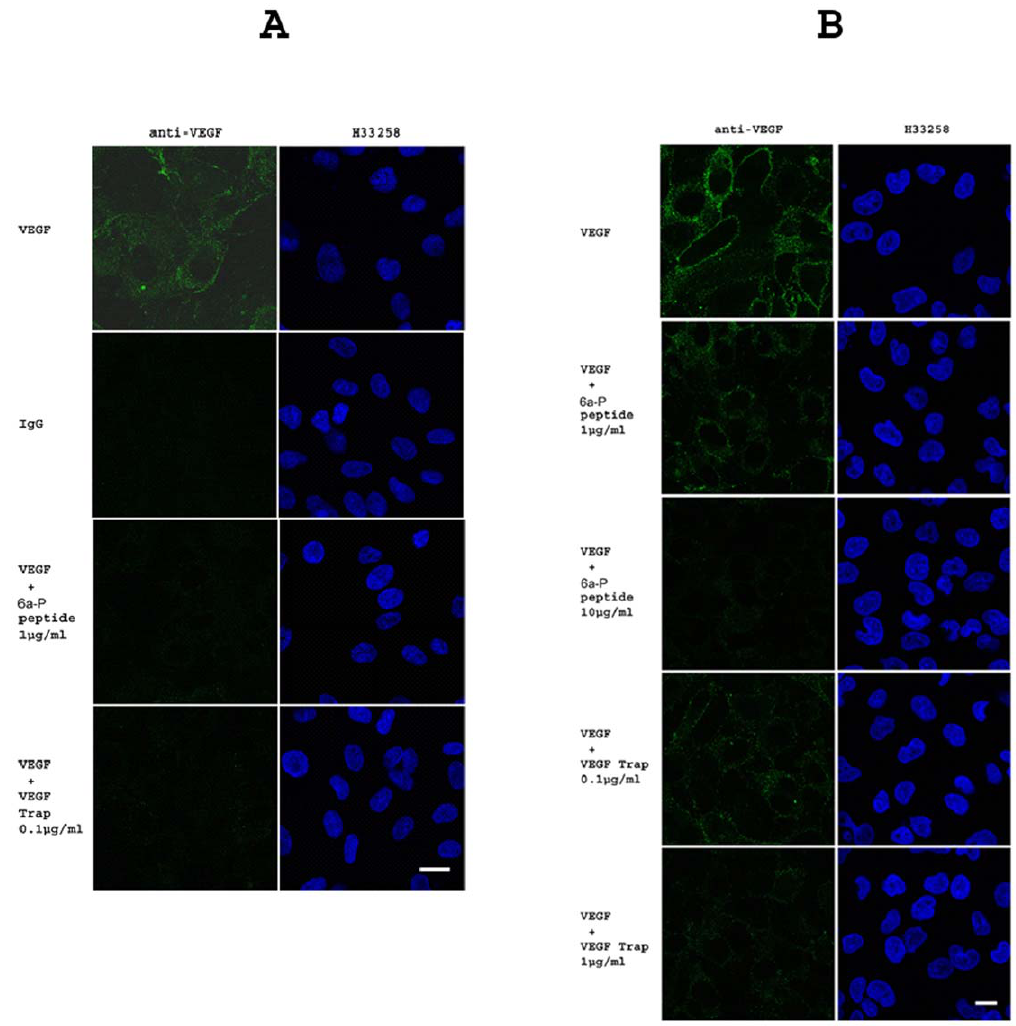
Figure 2. 6a-P peptide decreases VEGF binding activity to cell surface by immunocytochemistry. Immunocytochemistry was used to confirm the FACS results. VEGF (0.1 m g/ml) binding intensity on HUVECS is decreased when the peptide (1 m g/ml) or VEGF-Trap (0.1 m g/ml) are present (A) (Bar, 20 m m). Similar result is shown on human liposarcoma. VEGF intensity is decreased in dose-dependent manner by 6a-P peptide (B) (Bar, 20 m